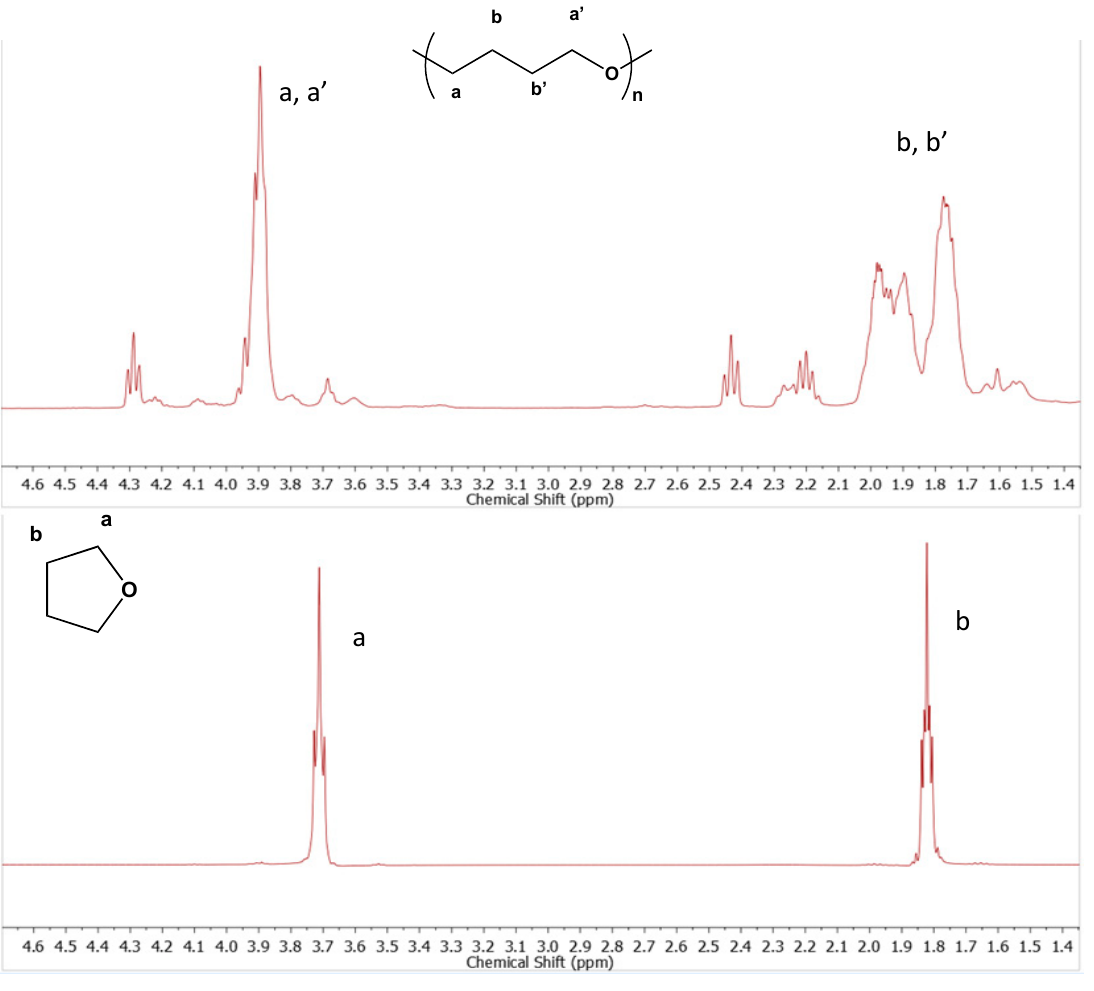
Figure 5. 1 H NMR spectra of THF (bottom) and poly(THF) formed with only 15 mM of CuBr as the sole reactant, and subjected to cyclization conditions of 60 °C while 24 h stirring.